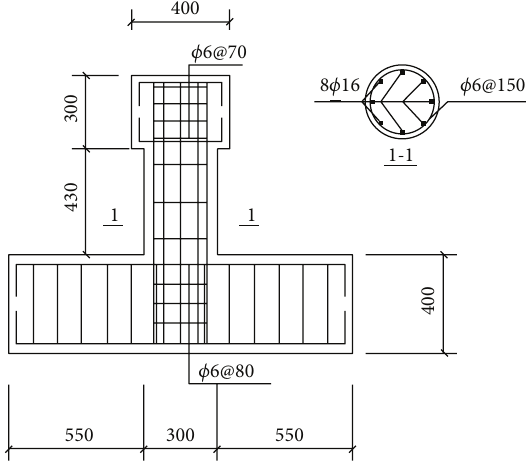
Figure 1: Details of the